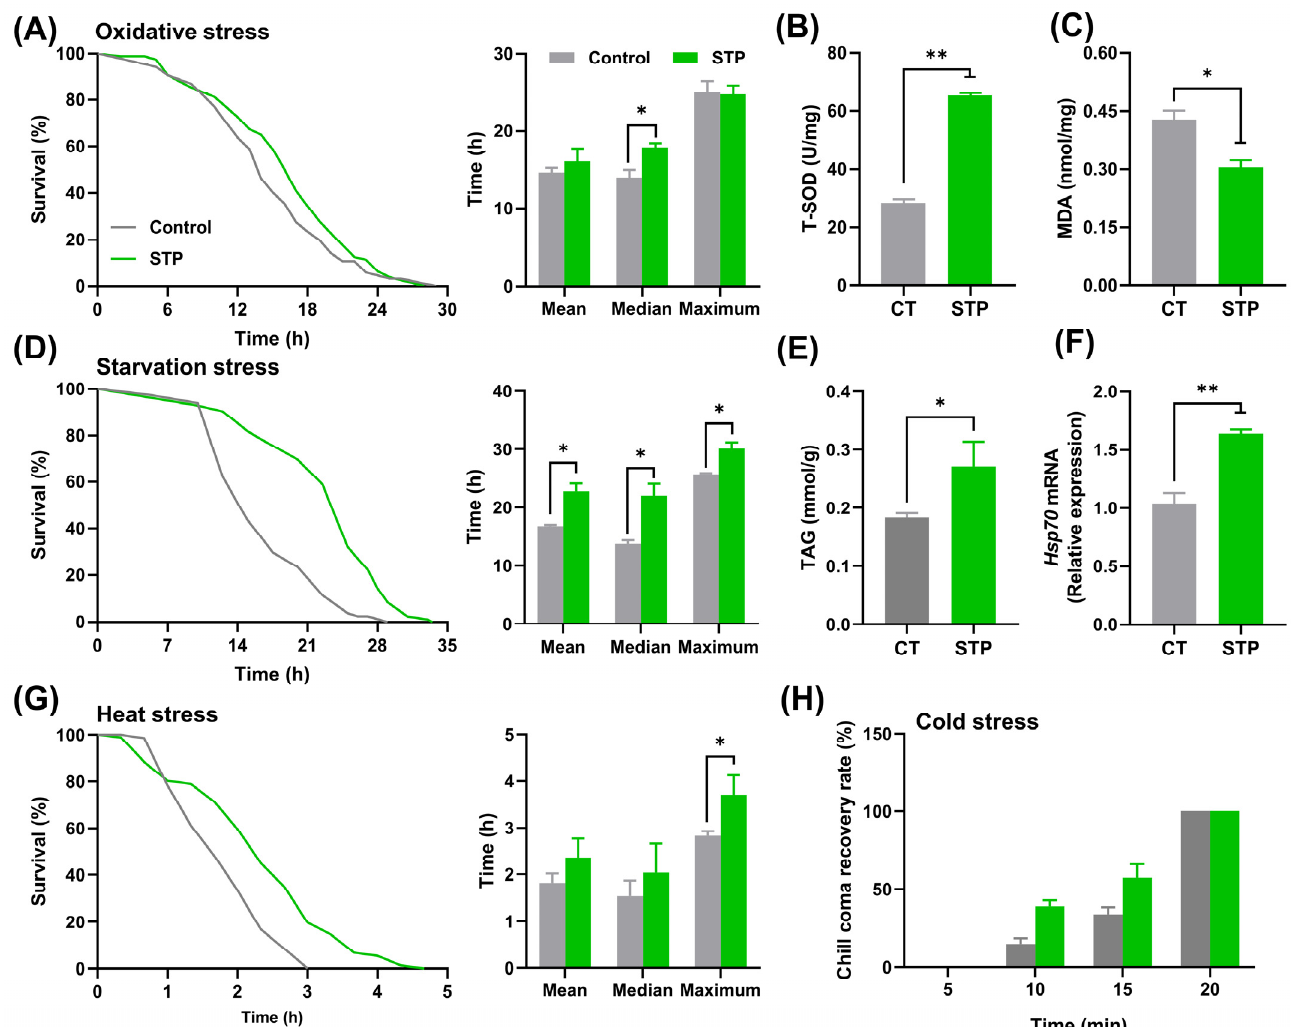
Figure 2. STP improved the resistance ability to stress in male flies. ( A ) Oxidative stress; ( B ) T-SOD activity; ( C ) MDA content; ( D ) Starvation stress; ( E ) TAG content; ( F ) Gene expression level of Hsp70 ; ( G ) Heat stress; ( H ) Cold stress. Data are shown as mean ± SEM. Statistical test: two-tailed unpaired t-test (* p < 0.05 and ** p < 0.01 vs. CT group).